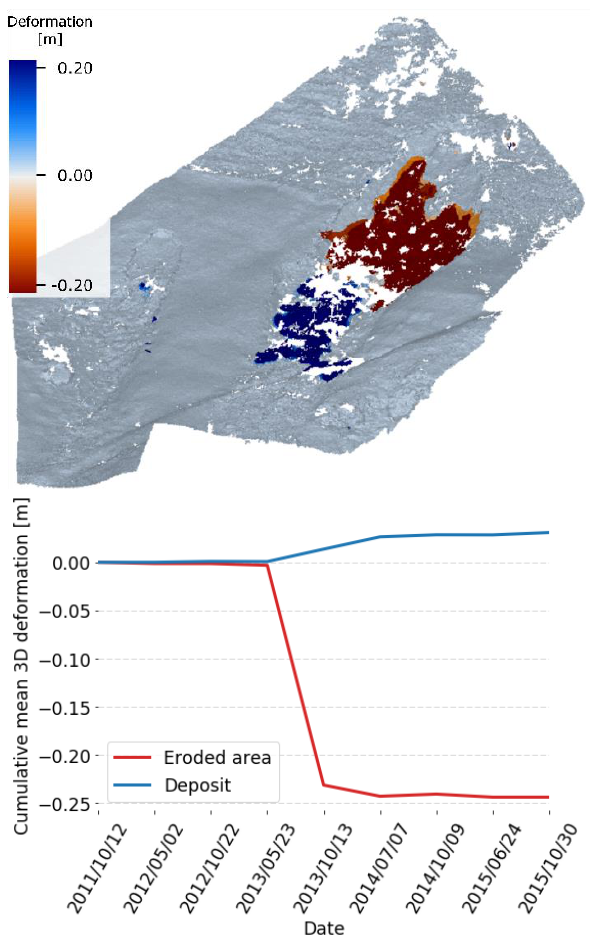
Figure 2 (top). Oblique view of the point cloud coloured by mean 3D deformation per object between 2013/05/23 and 2013/10/13, showing movement of the sliding mass at landslide L2. (bottom) Cumulative mean 3D deformation of the eroded area and the deposit of landslide L2 for the point cloud time series.